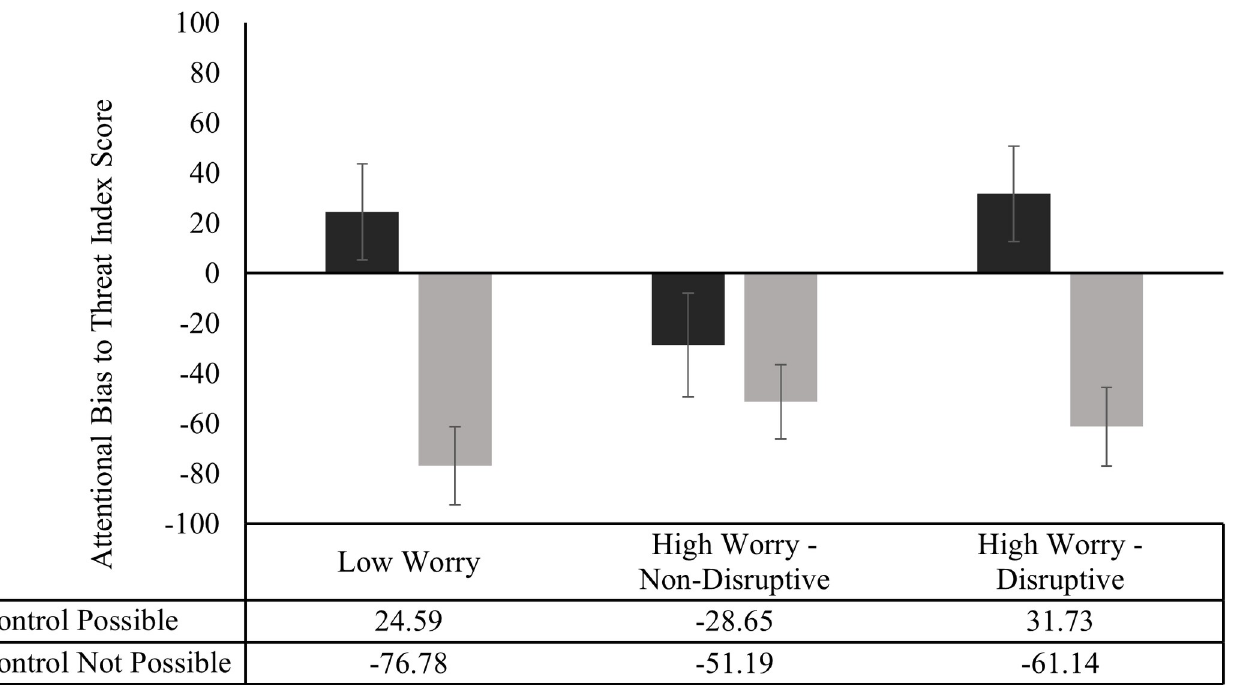
PLOS ONE | https://doi.org/10.1371/journal.pone.0251350 May 13,